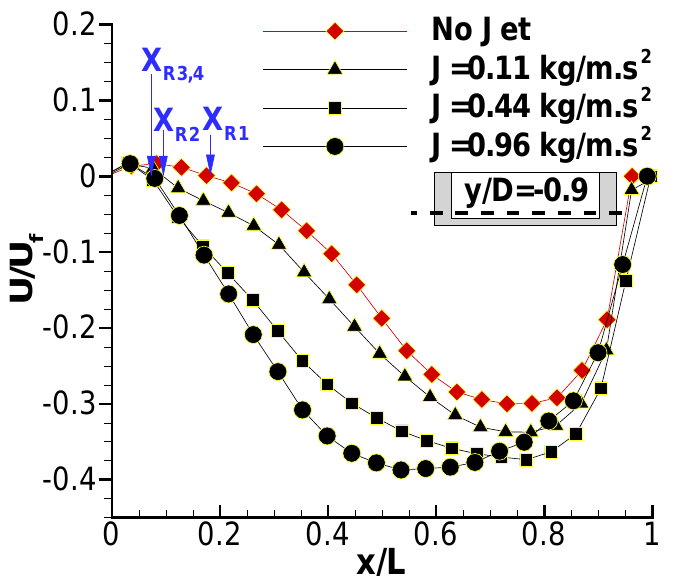
Figure 11. Distribution of U / U f along the cavity floor ( y / D = − 0.9) for Re D ≈ 50,000; sharp edge at LE; different J